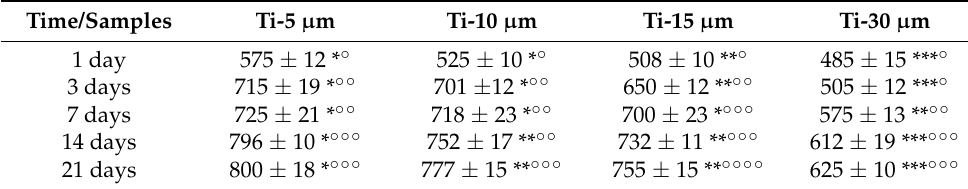
Table 3. Titanium ion release in ppb for the different samples studied after 1, 3, 7, 14, and 21 days of